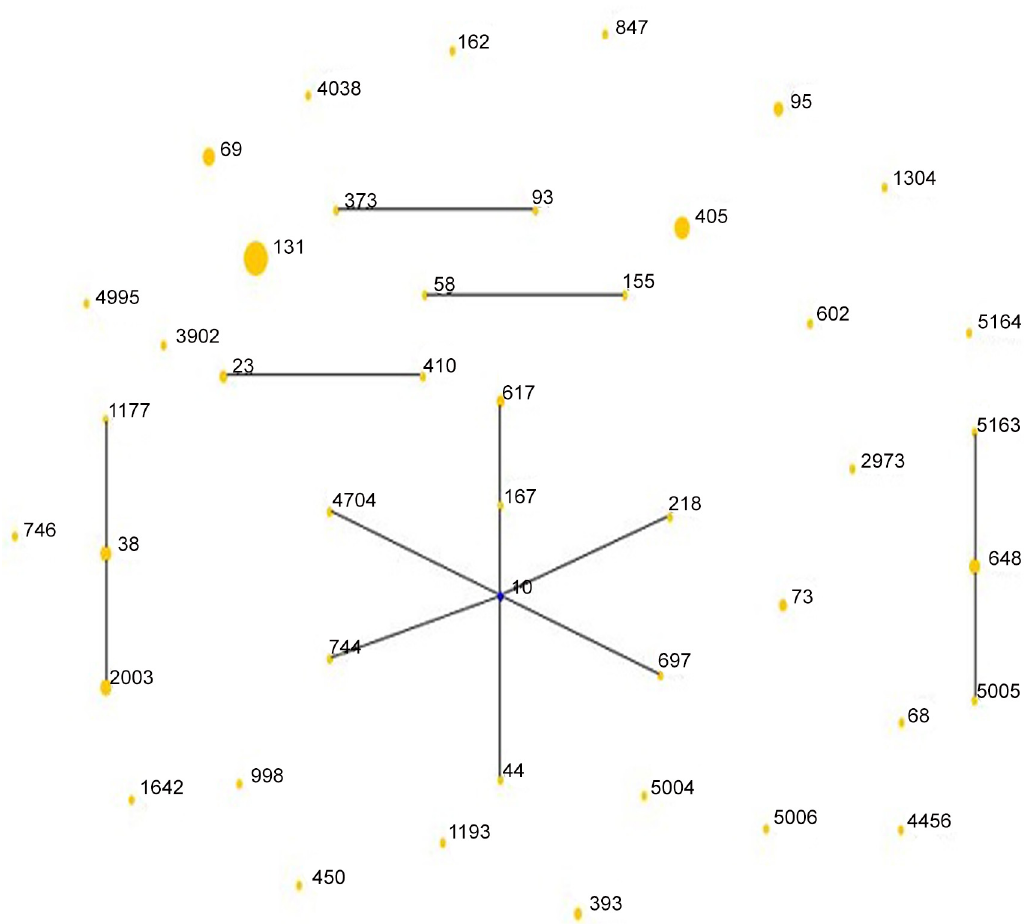
Fig 1. The rough sketch produced by eBURST with the stringent (default) group definition, representing ninety E . coli isolates from bloodstream infections: there were 24 singletons, 5 groups (group1: ST93, ST373; group2: ST58, ST155; group 3: ST23, ST410; group 4: ST38, ST1177, ST2003; group 5: ST648, ST5005, ST5163) and 1 clonal complex (ST10, ST167, ST617, ST218, ST697, ST44, ST744, ST4704) which was radial. The blue dot in it indicated putative founder but the line distances have no significance. The area of each yellow circle corresponded to the prevalence of the ST in the MLST data of this